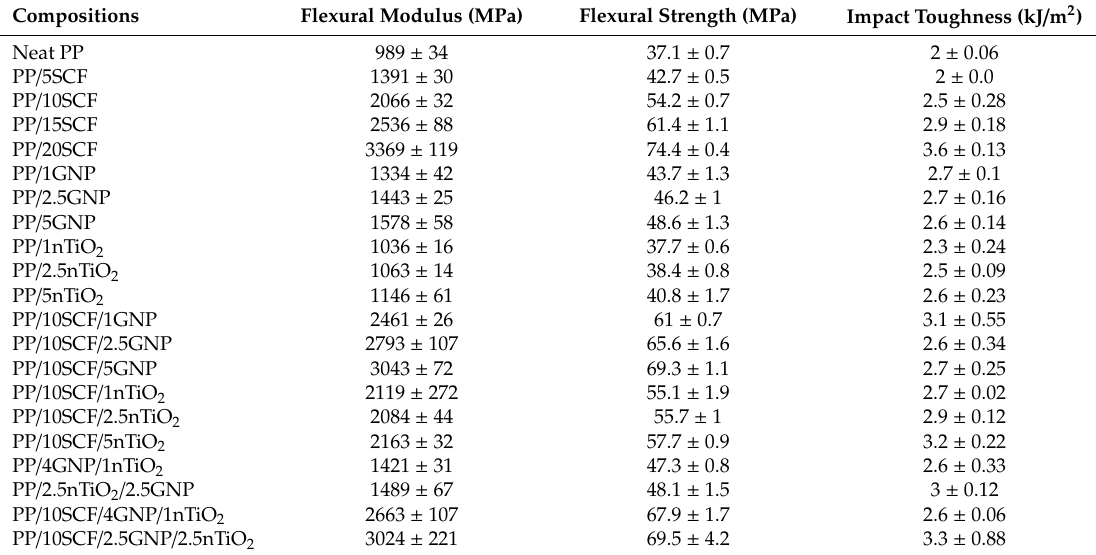
Table 7. Flexural test results and impact toughness of the